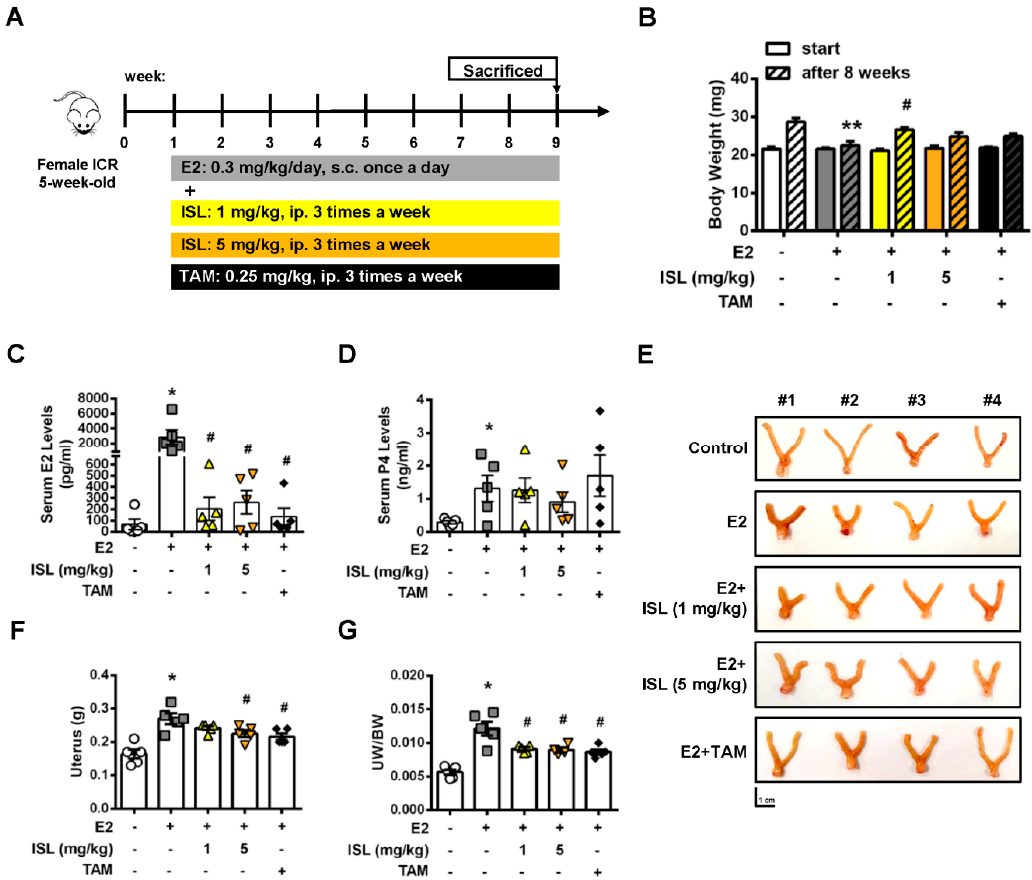
Figure 7. Effects of ISL treatment on E2-induced mouse uterine myometrium growth. ( A ) Schematic design of the in vivo mice uterine myometrium hyperplasia model. ( B ) Mice body weights at the beginning and the end of the study. After eight weeks treatment, mice were sacrificed, and serum ( C ) estradiol and ( D ) progesterone concentrations were measured using ELISA. ( E ) The uterus was photographed, ( F ) the weights of uteri were measured and ( G ) normalized to whole body weight. Scale bar = 1 cm. Data are represented as means ± SEM ( n = 5 each group). * p < 0.05, ** p < 0.01 compared with the control group. # p < 0.05 compared with the E2-treated